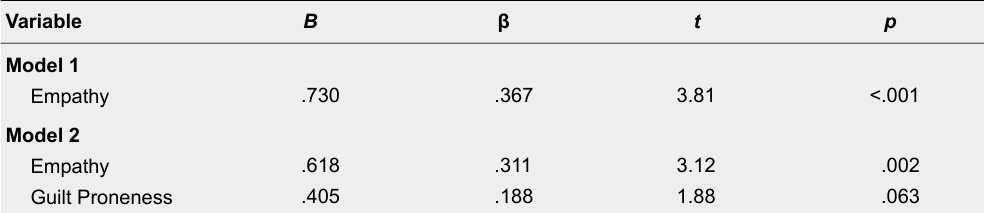
Stepwise Regression on Prosocial Behaviour in the Male Sample. Guilt Proneness Does not Predict Additional Variance Beyond